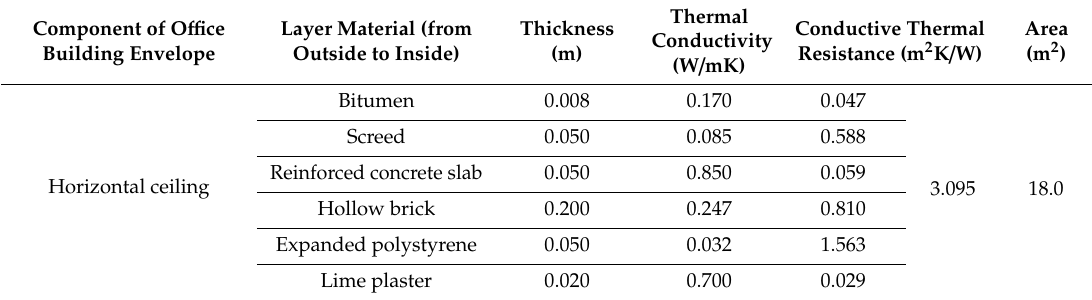
Table 10. Building envelope characteristics of the o ffi